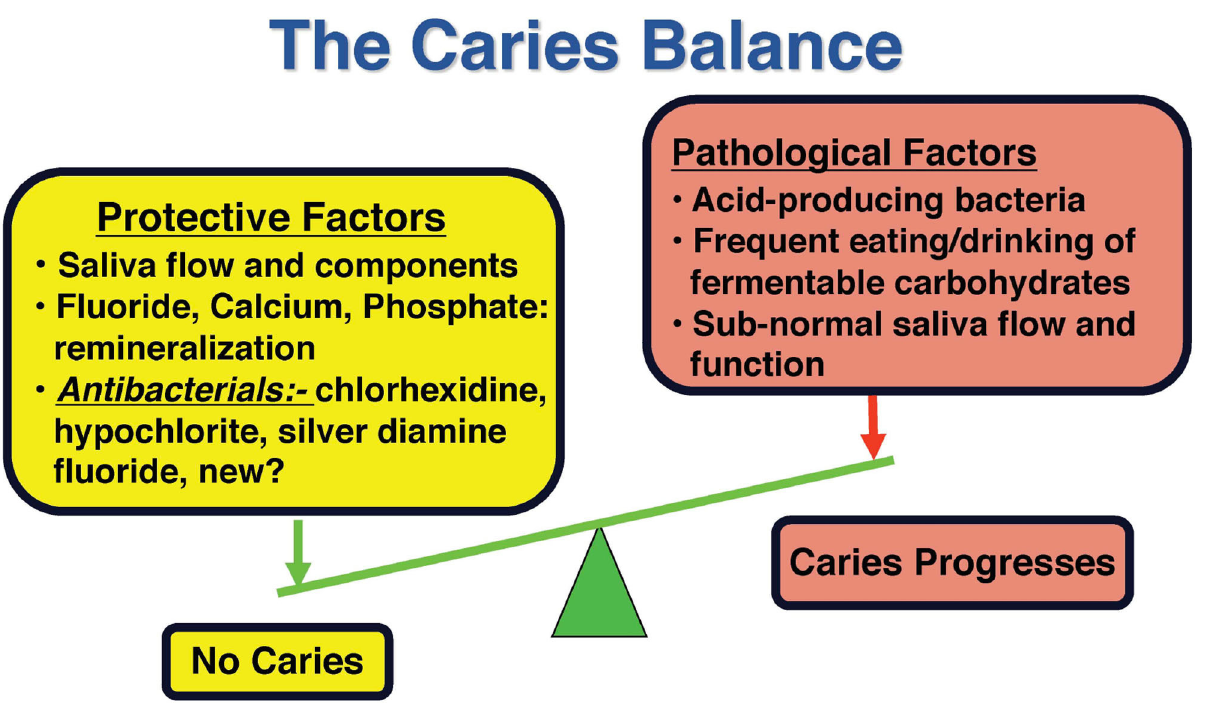
FIGURE 1 | Schematic representation of the caries balance. Modified from Featherstone with permission